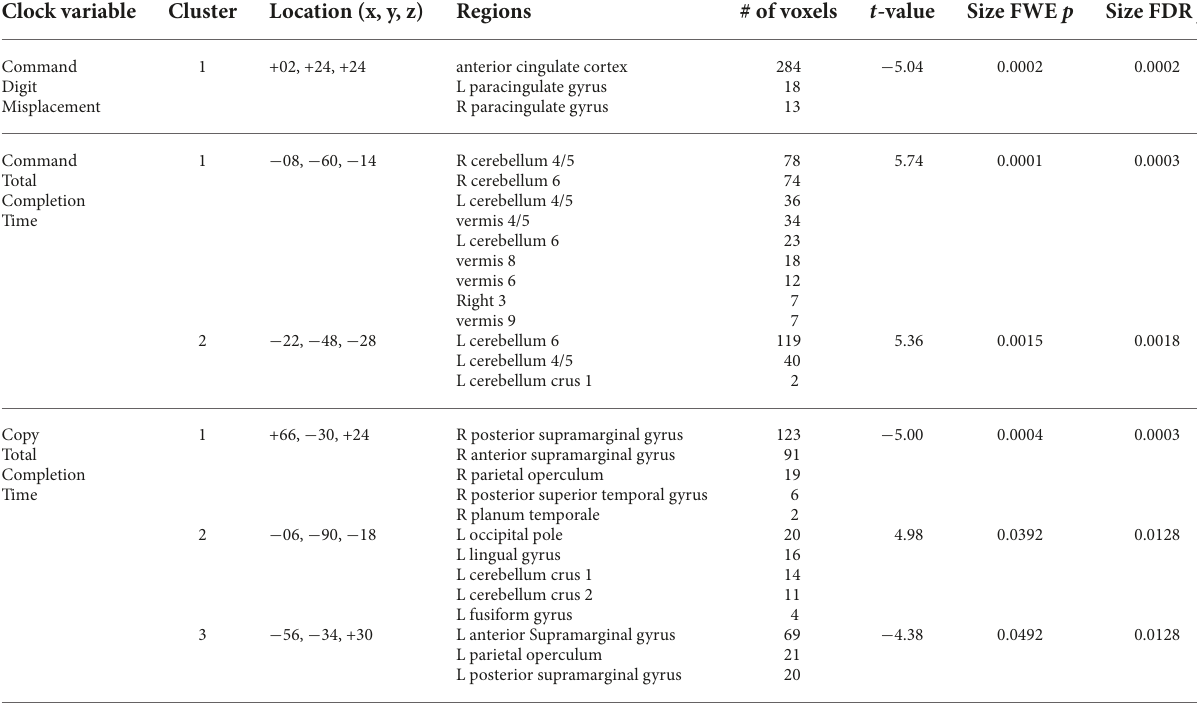
TABLE 4 Clusters demonstrating significant associations between BNM connectivity and digital clock